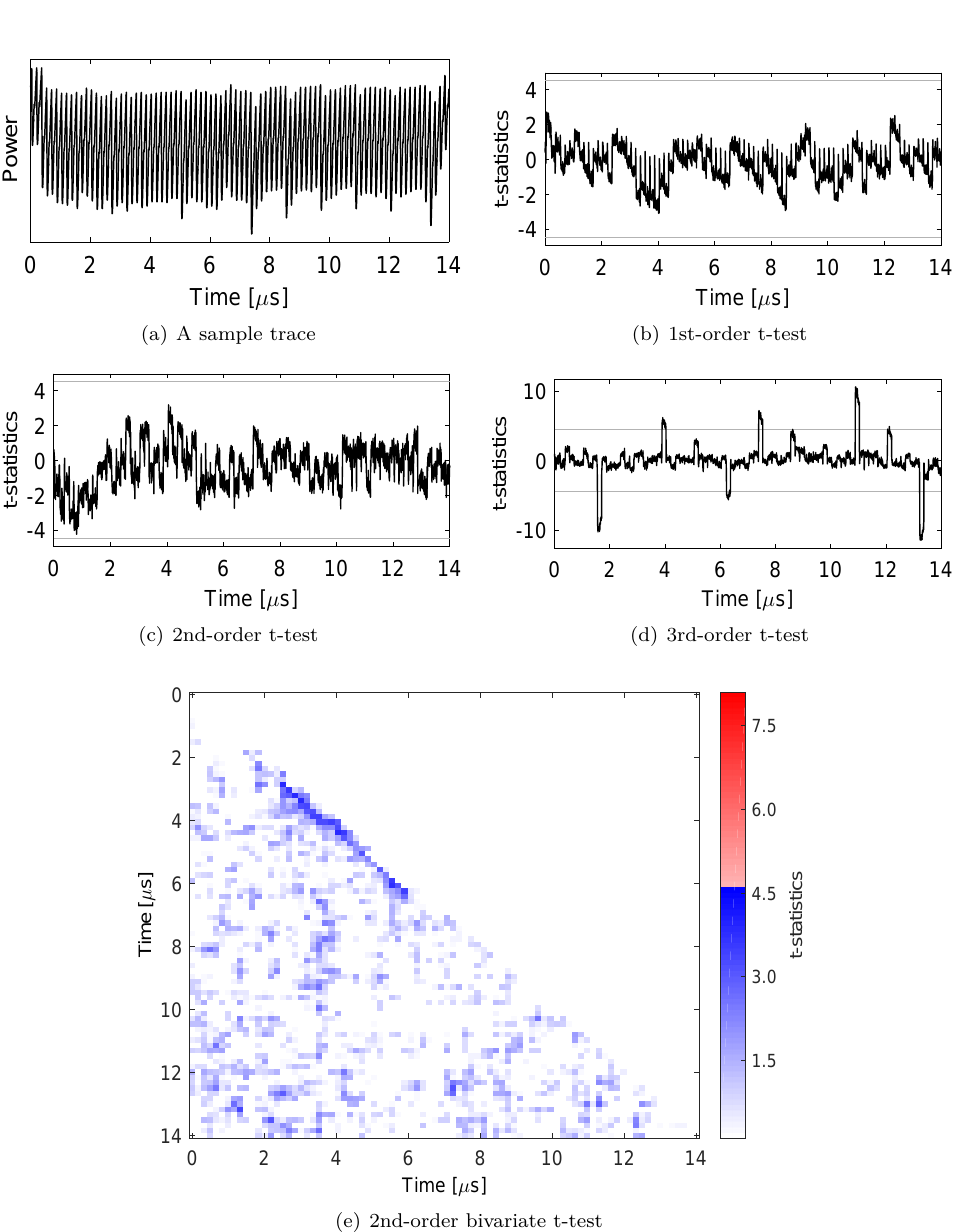
Figure 11: Experimental analysis of our second-order secure round-based PRINCE en- cryption design, 100 million